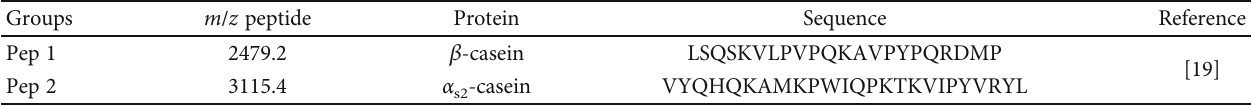
Table 2: Peptide information.